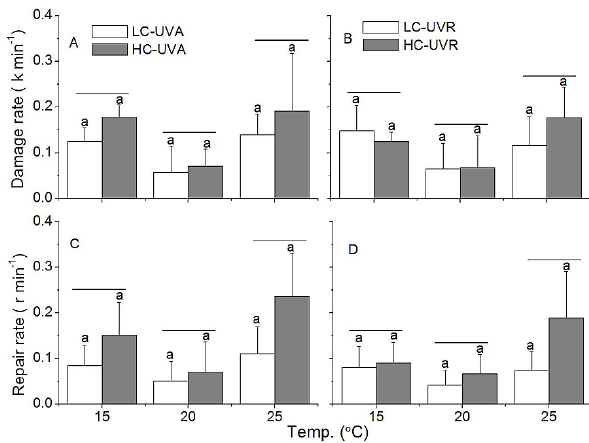
Fig. 3. Damage ( k , in min − 1 ) and repair rates ( r , in min − 1 ) of P. tri- cornutum cells grown at ambient (LC, white bars) and elevated CO 2 (HC, black bars) concentrations while exposed to radiation treat- ments with UV-A, (A) and (C) , or UV-A+B, (B) and (D) , at 15, 20 or 25 ◦ C. The bars represent the means ( n = 3) and the vertical lines are the standard deviation. Lines above histogram bars indi- cate significant difference between LC and HC, and the same letters indicate insignificant differences among the temperature treatments within the HC- or LC-grown cells.